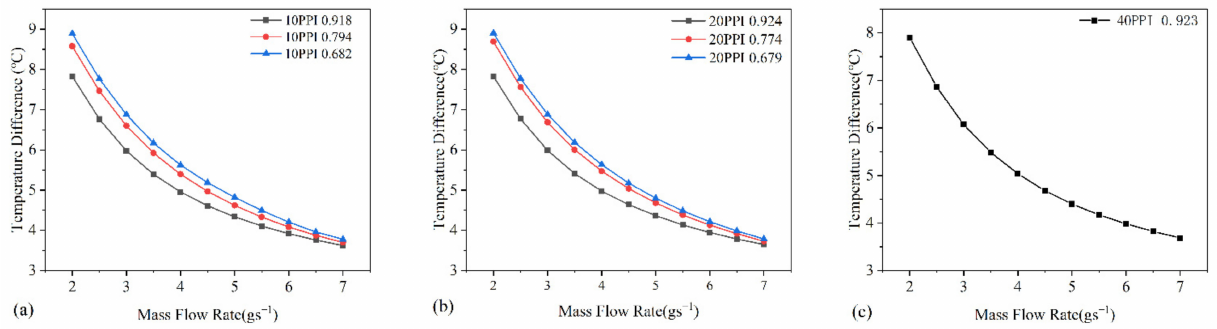
Figure 7. The temperature difference of the battery when using AFHS with different parameters: ( a ) 10 PPI aluminium foam; ( b ) 20 PPI aluminium foam; ( c ) 40 PPI aluminium